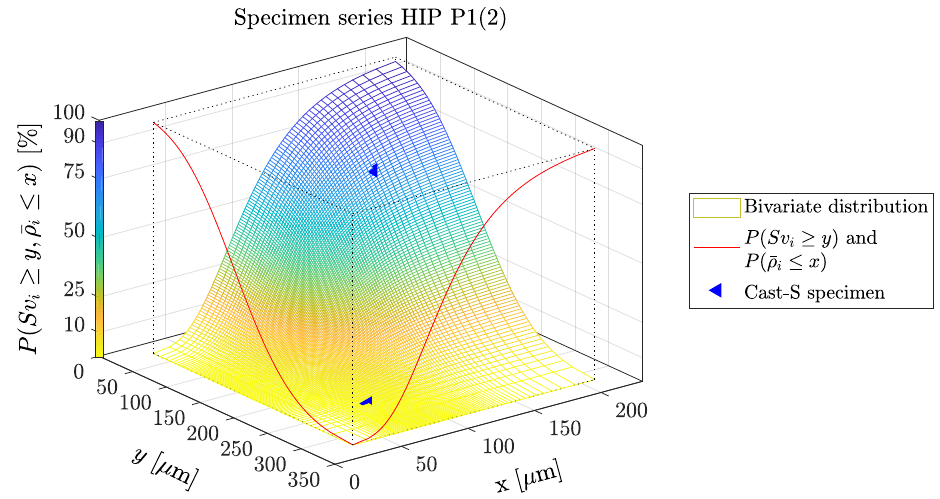
Figure A2. HIP P1(2) bivariate distribution of Sv i GEV distribution and ρ